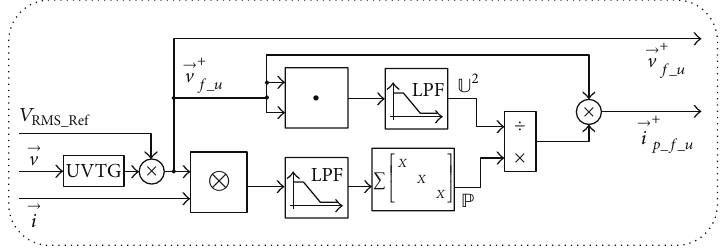
Figure 7: Reference signals generator scheme for the iUPQC with SRF-PLL and UVTG.